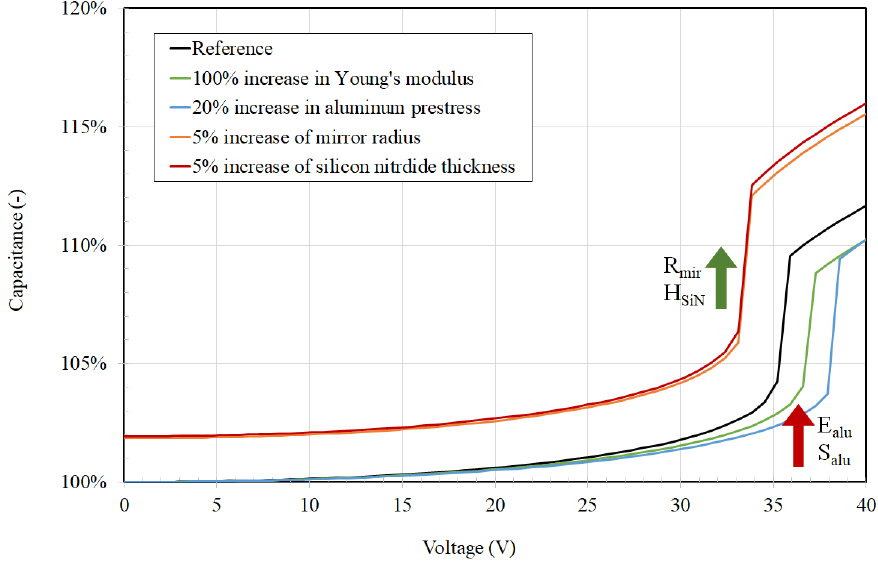
Figure 11. Effects of multiple parameters on the capacitance.